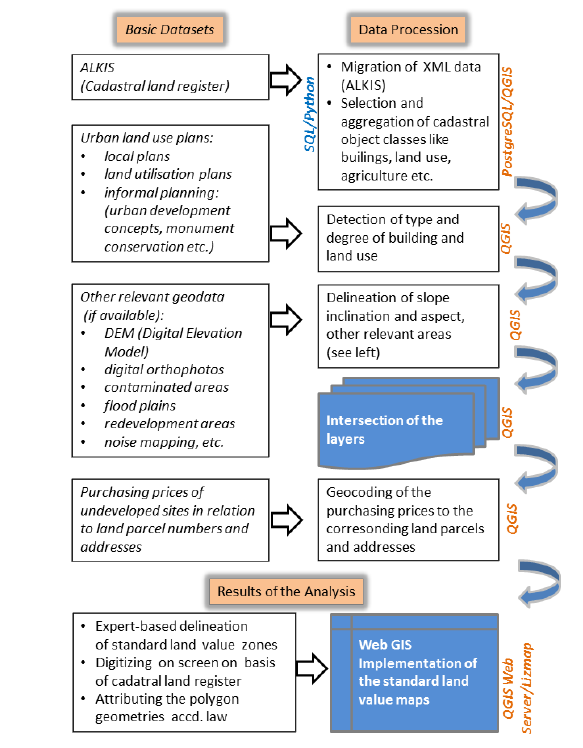
Figure 2: Process schema of the derivation of the standard land values and its map